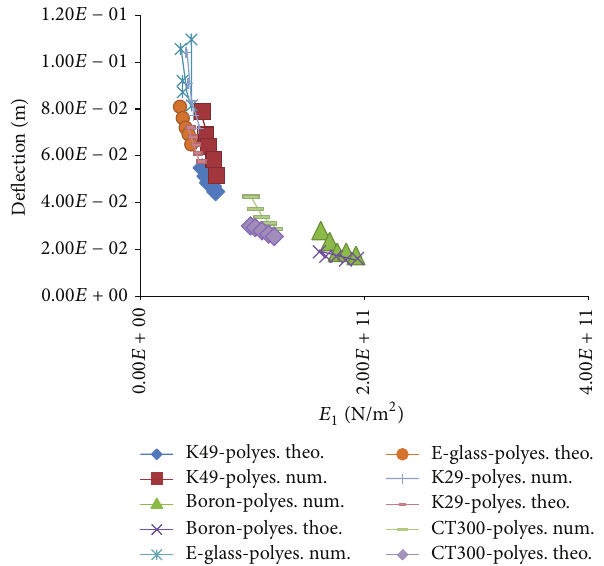
Figure20:Comparisonofnumericalandtheoreticalresultsofeffect of 𝐸 1 on spring deflection based on fibers variation with polyester.